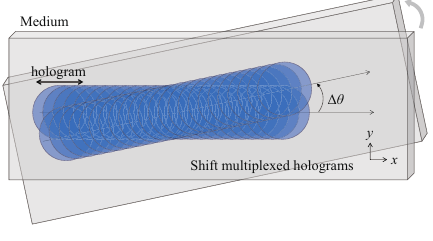
Figure 3. Recording method shift-peristrophic multiplexing.